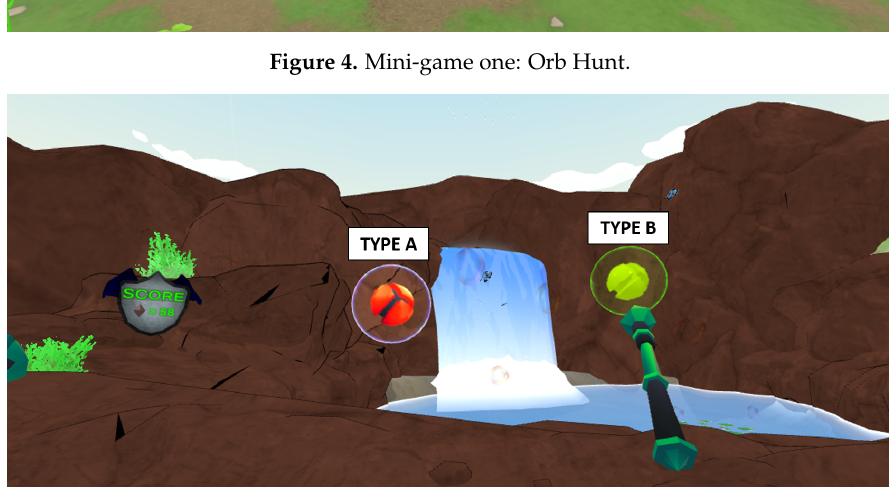
Figure 5. Mini-game two: Bubble